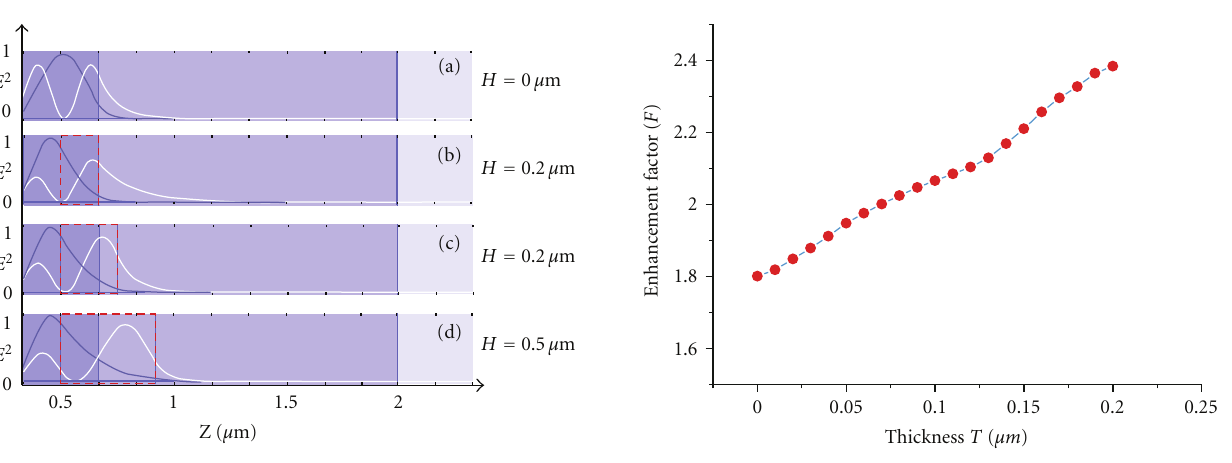
Figure 9: The enhancement factors F of the structure with thick- ness T .